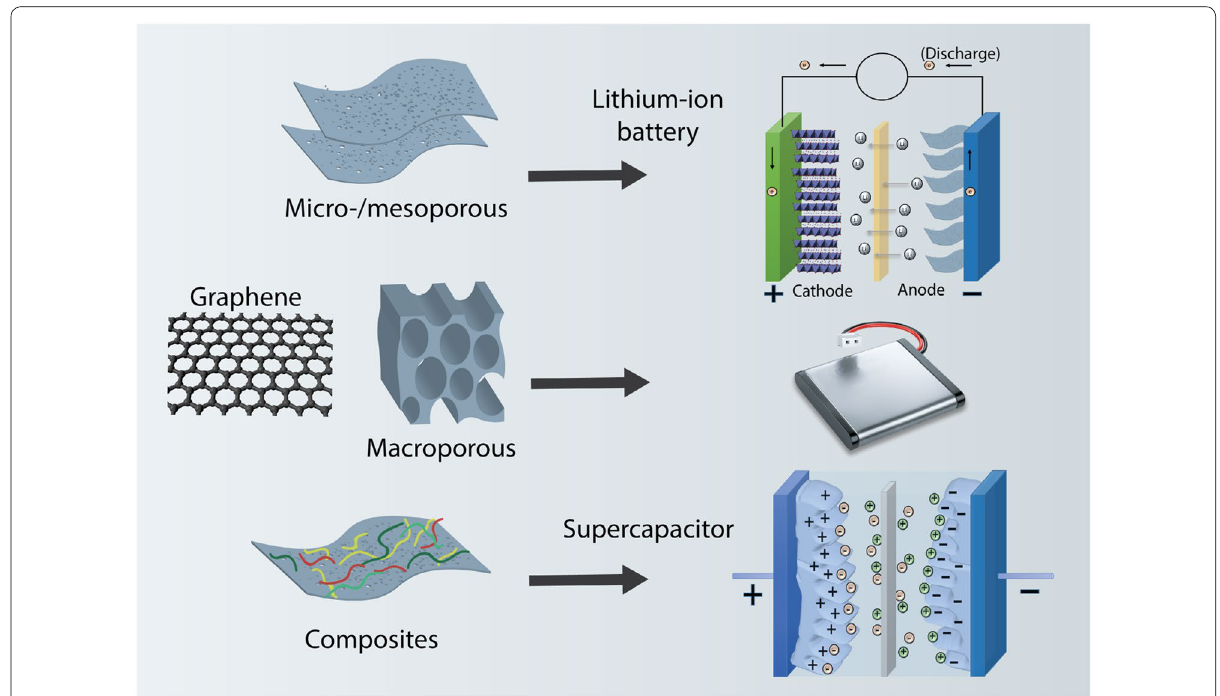
Fig. 1 Schematic representation of graphene‑based materials and their applications in energy